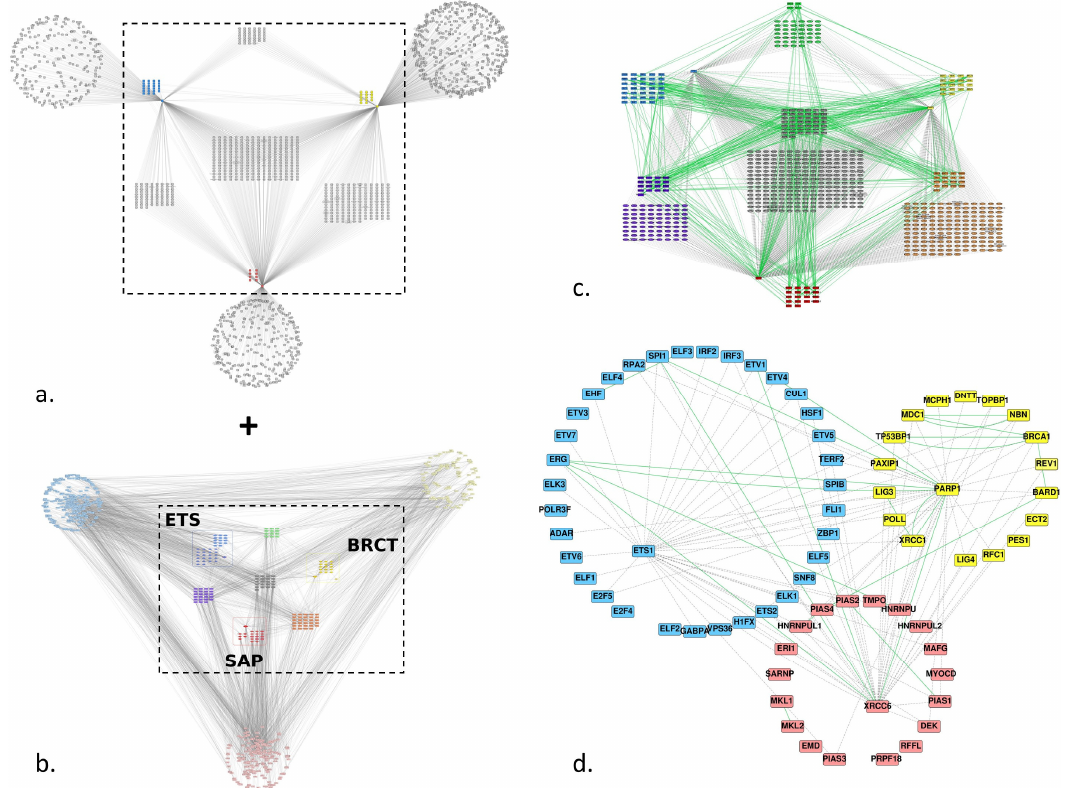
Figure 3. Predicted and experimentally identified protein-protein interaction (PPI) network of Ets-1, PARP-1, Ku70 and proteins that contain one of the ETS, BRCT or SAP homologous domains: ( a ) first-neighbour predicted network of Ets-1, PARP-1 and Ku70 (XRCC6); predictions were retrieved from FpClass; the group of ETS homologs is colored blue, the one of BRCT homologs is colored yellow and the one of SAP homologs is colored red; ( b ) global first neighbor PPI network; this is the same network as in Figure 2a; ( c ) union of the center part of the networks ( a , b ), the color code of the nodes is the same as in Figure 2; edges are colored green for experimentally established interactions and dashed/grey for predicted ones; ( d ) the same network as ( c ), keeping only the proteins of the three groups of